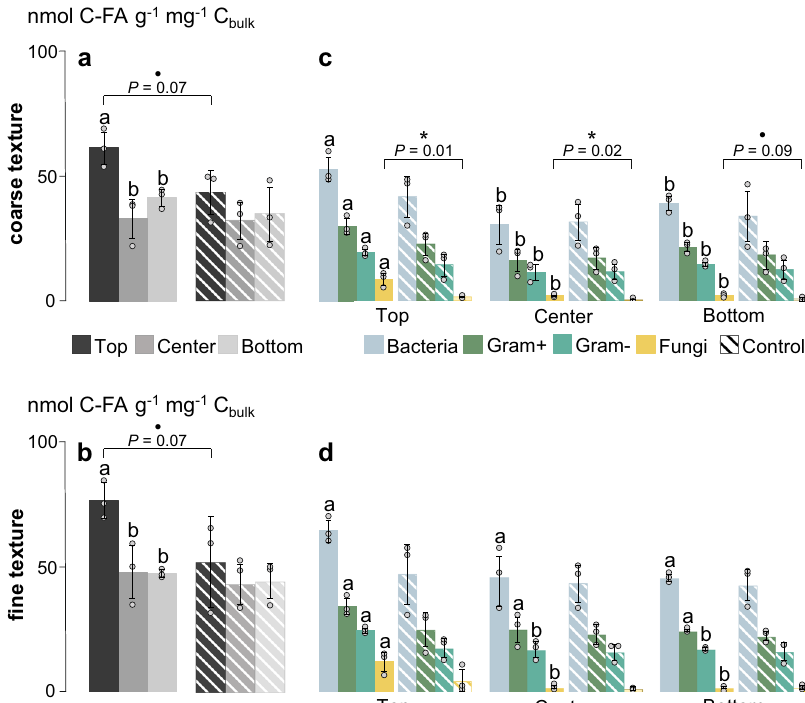
Fig. 4 Community structures and functionality of microorganisms. The total abundance of phospholipid fatty acids (PLFA) normalized for bulk C in nmol C-FA g − 1 mg − 1 C bulk (means, SDs displayed with errors bars, n = 3 independent replicates) in soil with ( a ) coarser and ( b ) fi ner texture, divided into four microbial subgroups in ( c ) coarse-textured and ( d ) fi ne-textured soil. Signi fi cance levels indicated by dots and asterisks (* P < 0.1, * P < 0.05) represent differences between litter treatment and controls, and lowercase letters represent signi fi cant ( P < 0.05) differences between top, center, and bottom layers. Control samples are displayed as hatched. Statistical signi fi cance between litter treatment was analyzed using an unpaired two-sided t -test and differences between depths using one-way ANOVA with Tukey ’ s HSD as the post-hoc